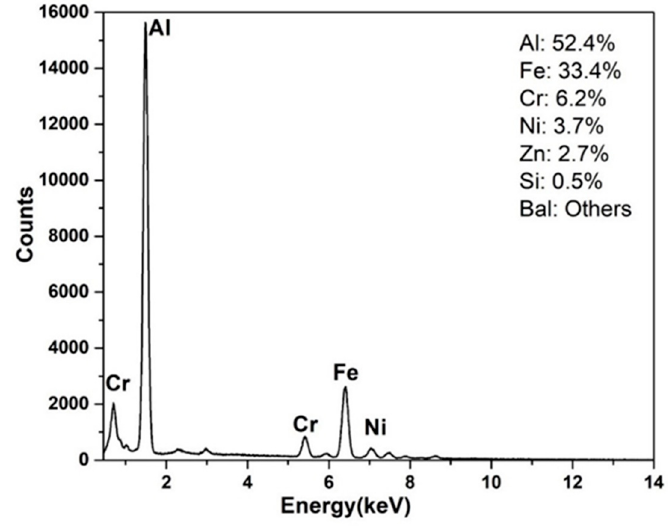
Figure 10. EDS analysis of the IMC layer (AL-1) (See Figure 4).